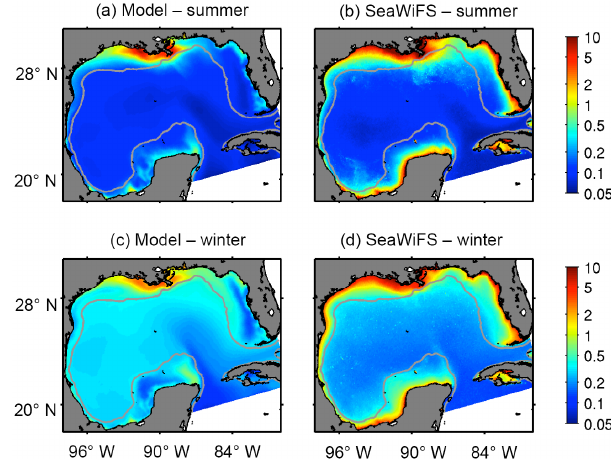
Figure 2. Spatial patterns of model and satellite chlorophyll. Com- parison between surface chlorophyll concentration (mgm − 3 ) de- rived from model outputs (a, c) and SeaWiFS (b, d) during summer and winter. Gray line depicts the 200m